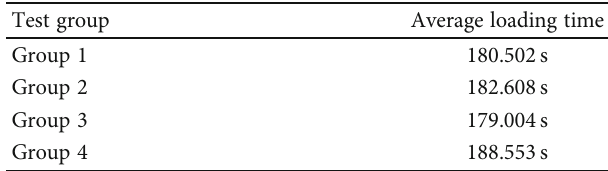
Table 2: Cluster statistics query function select statement test.